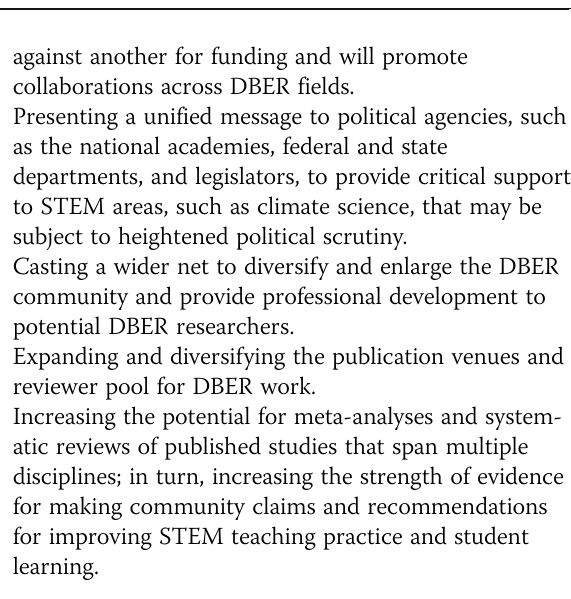
Fig. 3 Five basic types of interaction between the individual DBER fields that are expected to take place within the STEM DBER